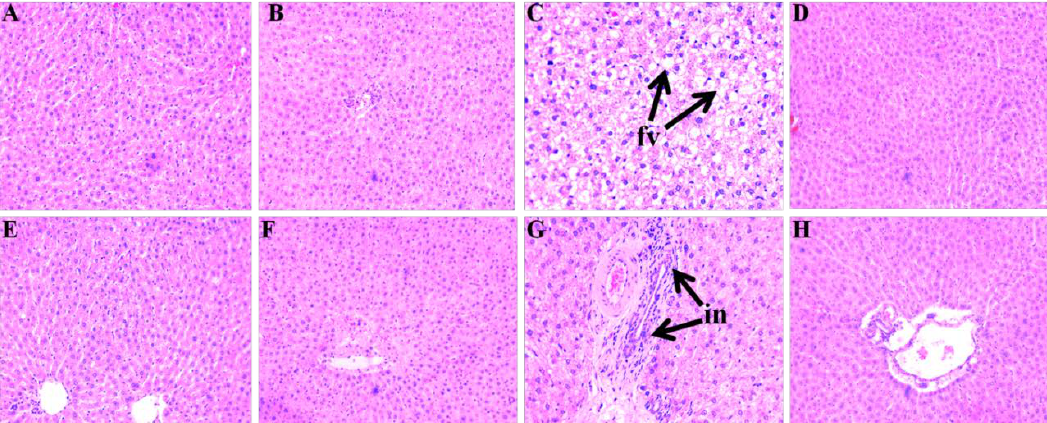
Figure 4. Effect of microalgae mixture treatment on inflammation and fat deposition in the liver. Haematoxylin and eosin staining of liver showing enlarged fat vacuoles ( A – D , marked as “fv”) (20×) and inflammatory cells ( E – H , marked as “in”) (20×) from C ( A , E ), CSC ( B , F ), H ( C , G ), HSC ( D , H ). C, corn starch-fed rats; CSC, corn starch rats treated with Scenedesmus dimorphus + Schroederiella apiculata ; H, high carbohydrate, high fat diet-fed rats; HSC, high carbohydrate, high fat rats treated with Scenedesmus dimorphus + Schroederiella apiculata